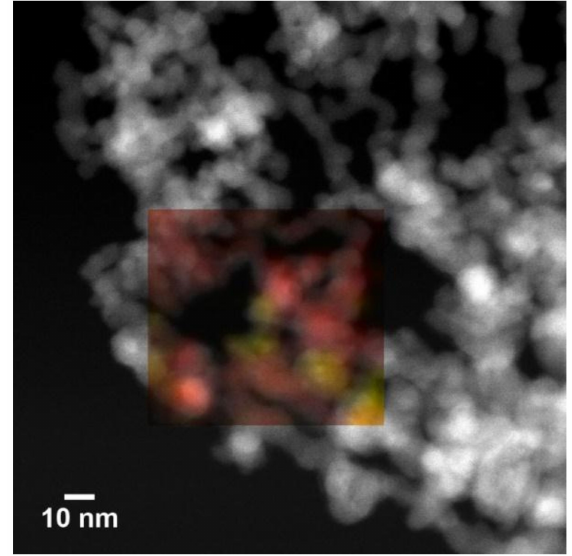
Figure 7. STEM-EDX elemental map of Fe (yellow) and Ti (red) in the as-prepared Fe/TiO x